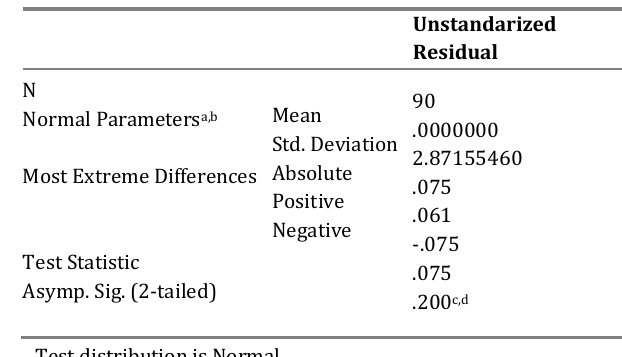
Table 5 Normality Data Result